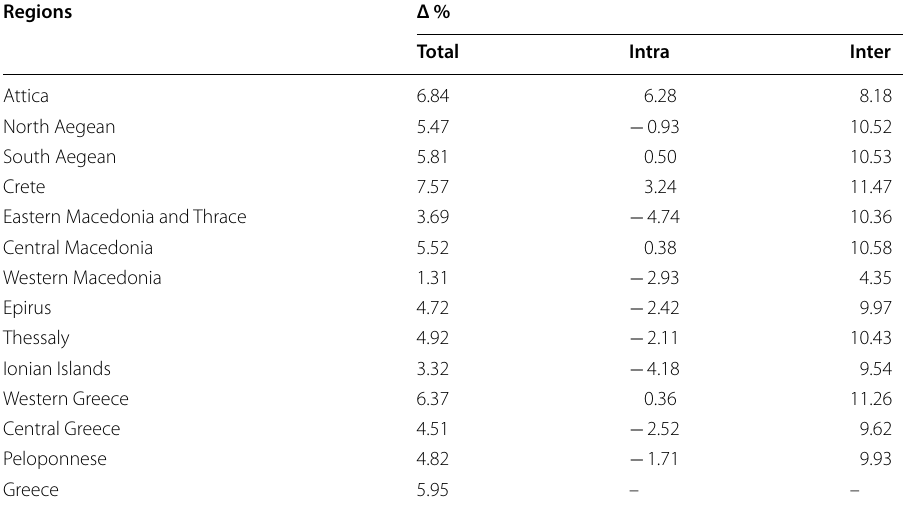
Table 5 Rate of change of the income multipliers: Greece, 2010–2013. Source: Calculations by the